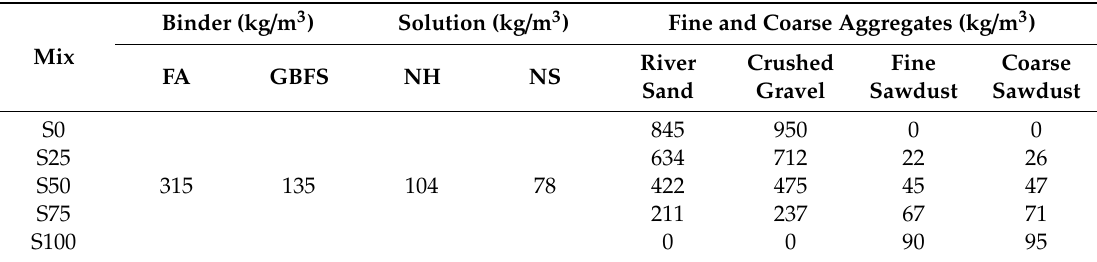
Table 2. Mix design of the proposed lightweight alkali-activated concrete (Kg/m 3 ).